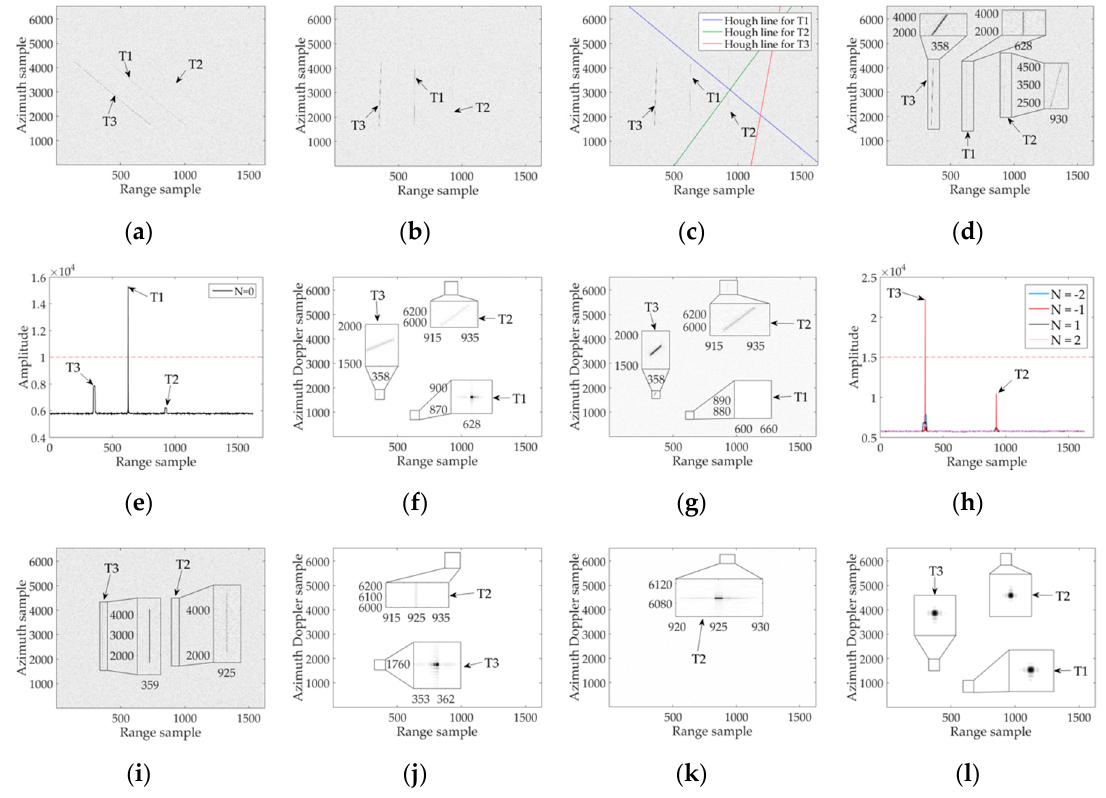
Figure 14. Simulation results for multiple target imaging under the linear trajectory condition: ( a ) range compressed signal; ( b ) pre-processing result; ( c ) Hough transform result; ( d ) BM-KT result for T1; ( e ) range profile for Figure 15d; ( f ) imaging result for T1; ( g ) multiple target filter result for separating T1; ( h ) blur matching result for T2 and T3; ( i ) BM-KT for T2 and T3; ( j ) imaging result for T3; ( k ) imaging result for T2; and ( l ) multiple target imaging result.